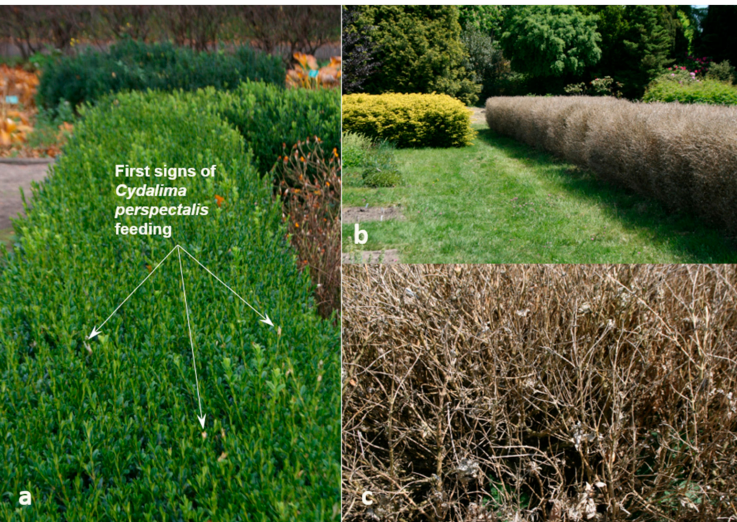
Figure 2. About a 50-year-old boxwood hedge damaged by C. perspectalis in the Botanical Garden in Ł ó d´z (Central Poland): ( a ) traces of feeding found one year after the first box tree moth was noticed in the garden despite the use of an insecticide (Ł ó d´z, October 2019); ( b ) wholly defoliated hedge in the Botanical Garden in Ł ó d´z in June 2021; ( c ) dead boxwood shoots without bark (June 2021). Photo ( a – c ): M.